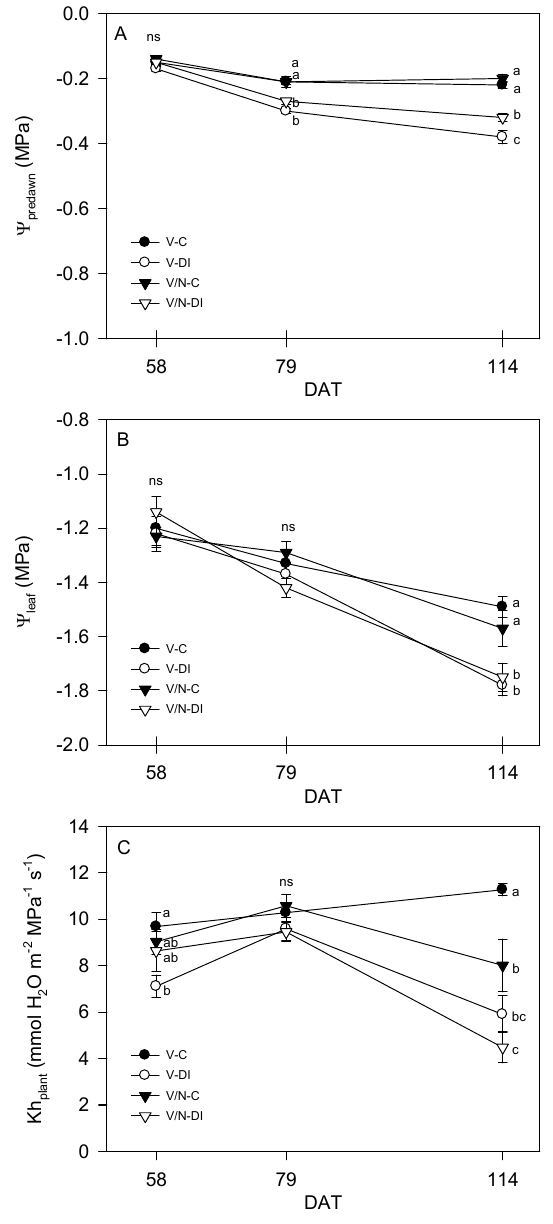
Figure 2. Predawn leaf water potential ( Ψ predawn ) ( A ), midday leaf water potential ( Ψ leaf ) ( B ), and whole plant hydraulic conductivity (Kh plant ) ( C ) in the ungrafted pepper plants (cultivar ‘Maestral’, V) and the plants grafted onto NIBER ® (V / N) grown under well-irrigated (C) and deficit-irrigated (DI) conditions. Measurements were taken on 58, 79, and 114 days after transplanting (DAT). Data are the mean values for n = 9 ± SE. For each studied time, di ff erent letters indicate di ff erences at p ≤ 0.05 (LSD test). n.s. indicate no significant difference.